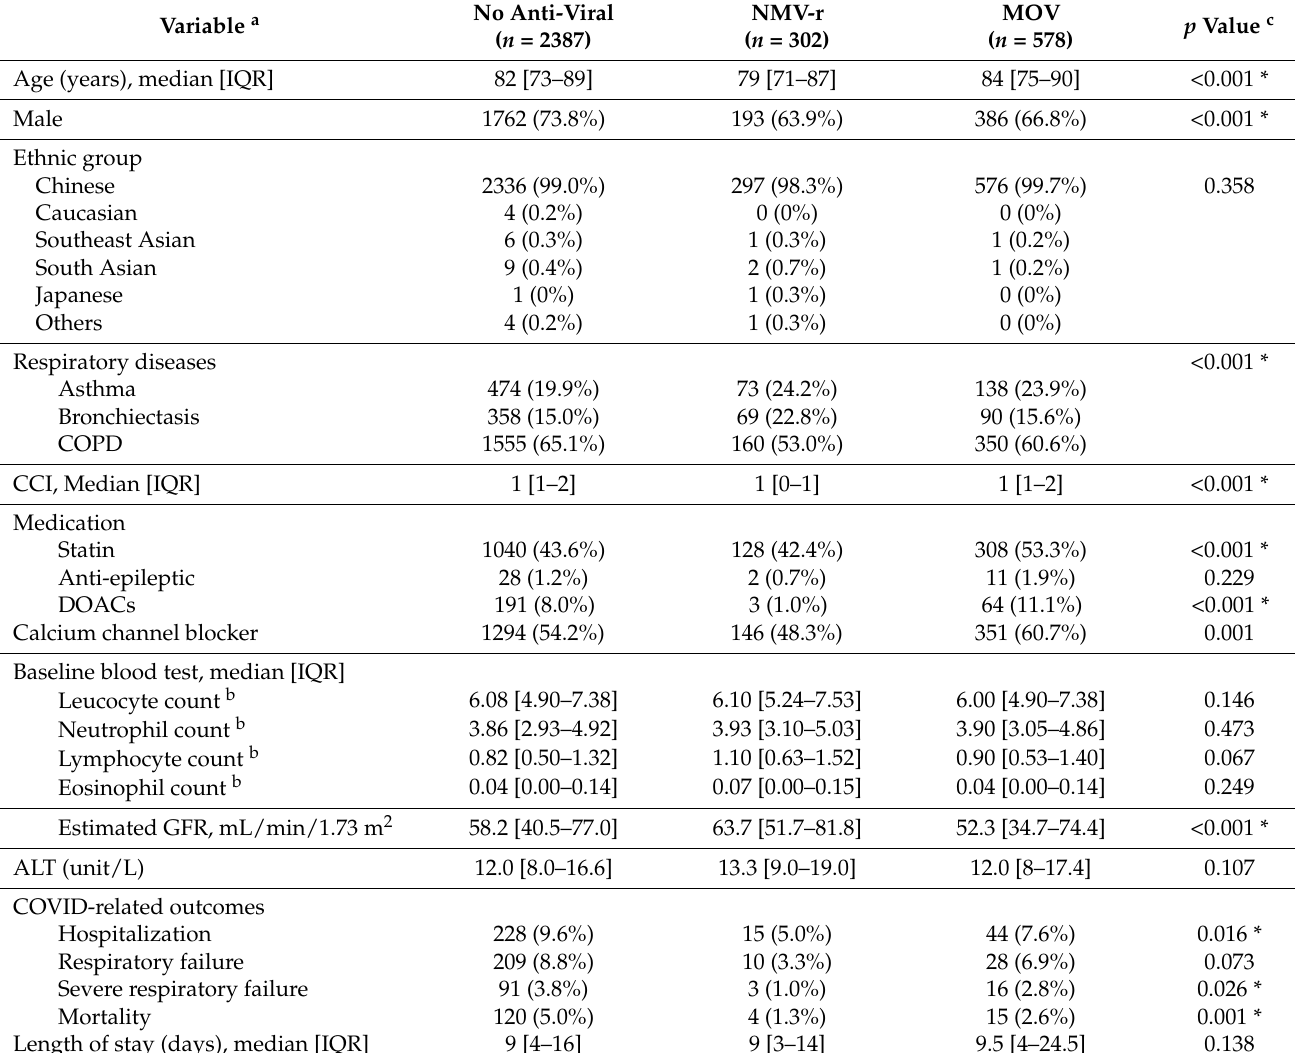
Table 1. Demographic and clinical characteristics of included